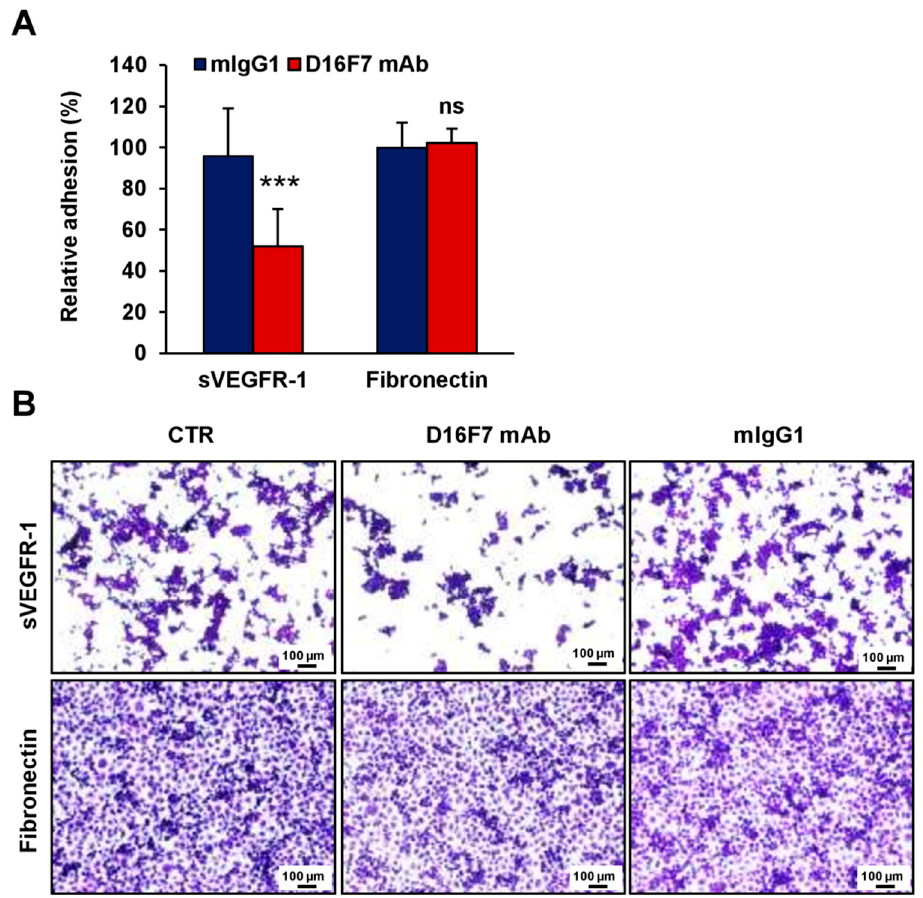
Figure 5. D16F7 mAb hampers the adhesion of human endothelial cells to sVEGFR-1. ( A ) Adhesion of human endothelial cells was evaluated in 96-well plates coated with recombinant human VEGFR-1 or with fibronectin as a control for antibody specificity. BSA was used to determine non ‐ specific adhesion. Cell adhesion to sVEGFR ‐ 1 and fibronectin was evaluated in the absence or presence of 5 μ g/mL D16F7 mAb or mouse IgG (mIgG1) after 2 h incubation. Each value represents the mean ± SD of 9 (sVEGFR ‐ 1) or 7 (fibronectin) total determinations from three independent experiments. Adhesion of melanoma cells to sVEGFR ‐ 1 ‐ or fibronectin ‐ coated wells, after subtraction of background values (nonspecific adhesion to BSA ‐ coated wells), was expressed as percent adhesion compared to cells incubated in the absence of any antibody. Statistical analysis of the differences between D16F7 mAb ‐ and mIgG1 ‐ treated cells was performed by Student’s t ‐ test in the case of adhesion to sVEGFR ‐ 1 (normal distribution; ***, p < 0.001) and by Mann–Whitney U test in the case of adhesion to fibronectin (non ‐ normal distribution; ns, non ‐ significant difference). ( B ) Representative photographs are shown for each experimental condition (100× magnification). The scale bars represent 100 μ m. CTR, control (i.e., untreated cells).